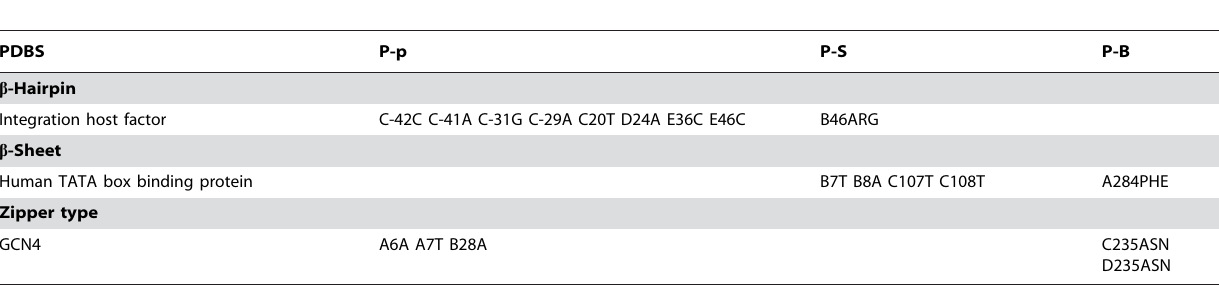
Table 3. Hubs identified in the component graphs of DNA-binding proteins belonging to b -hairpin, b -sheet, and zipper-type